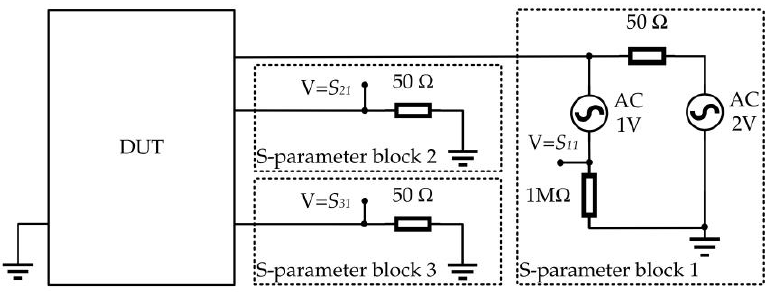
Figure 5. SPICE implementation of the measurement setup used to evaluate the passive part of the model: The three blocks connected at the DUT ports are used to emulate the three ports of a VNA.